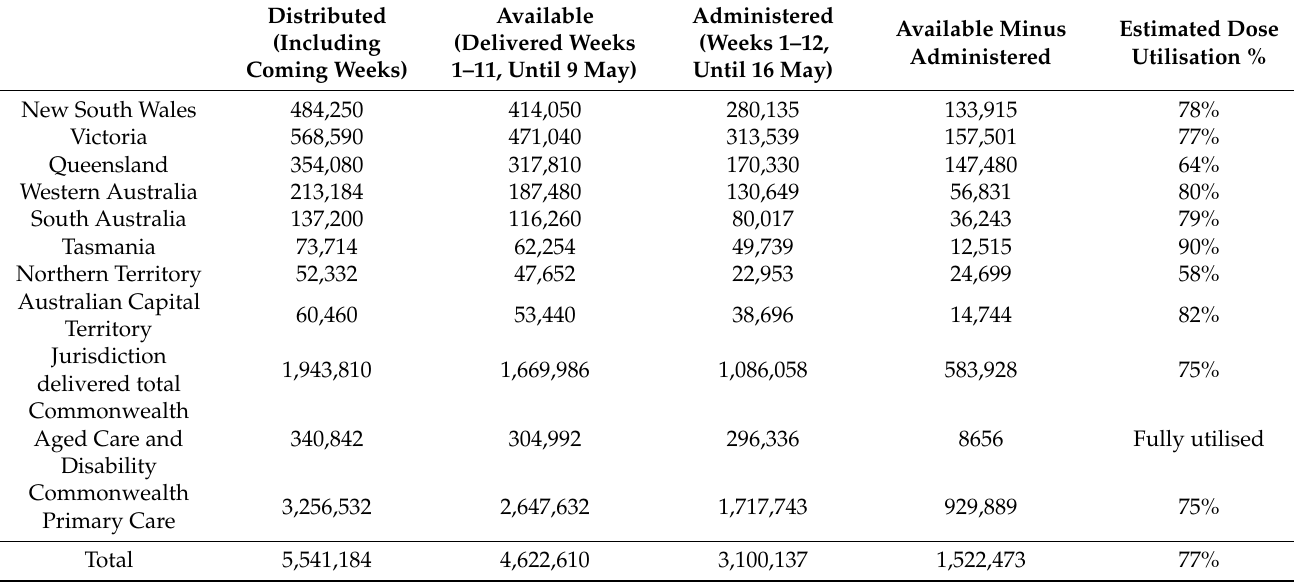
Table 4. Comparing the States and Territories through vaccine distribution and doses administered [82]. Last updated: 17 May